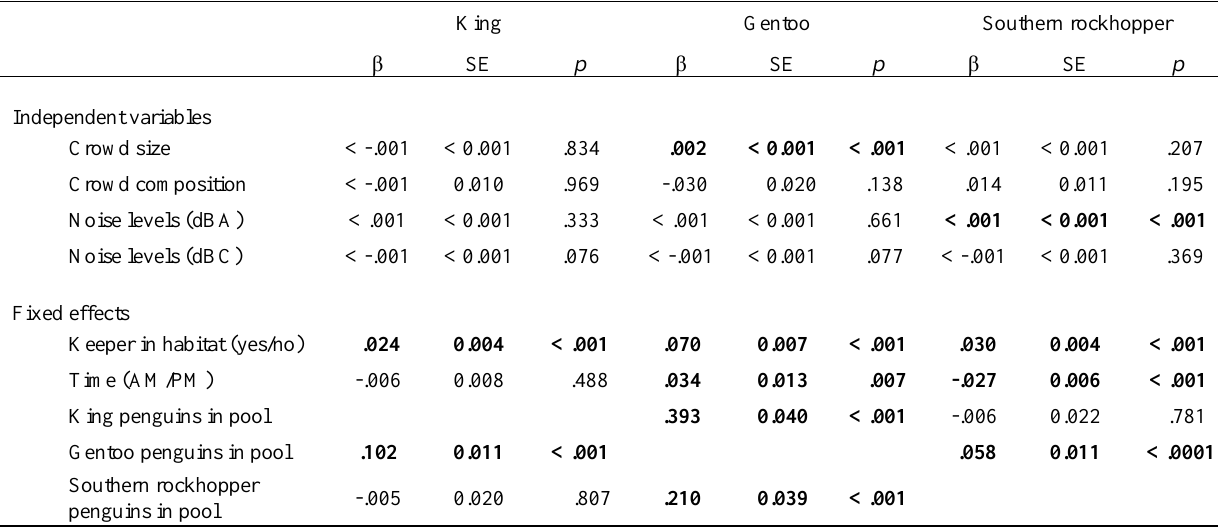
Variables Affecting Pool Use in King, Gentoo, and Southern Rockhopper Penguins at the Saint Louis Zoo King Gentoo Southern rockhopper β